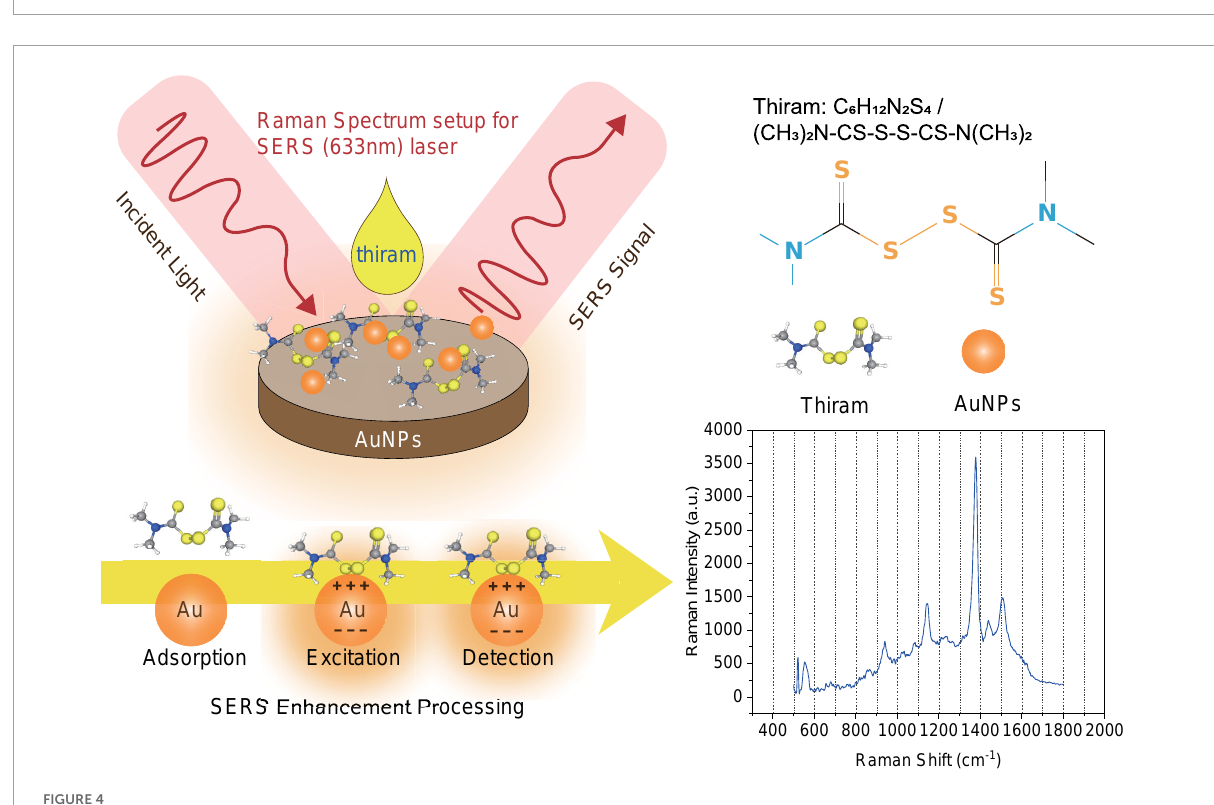
and a drop was dropped every 8 cm or so, and it was left to stand for several hours until it was completely dry. Take different varieties of apples and pears and scrub the surface. And after drying, respectively, apply thiram solution on the surface of the